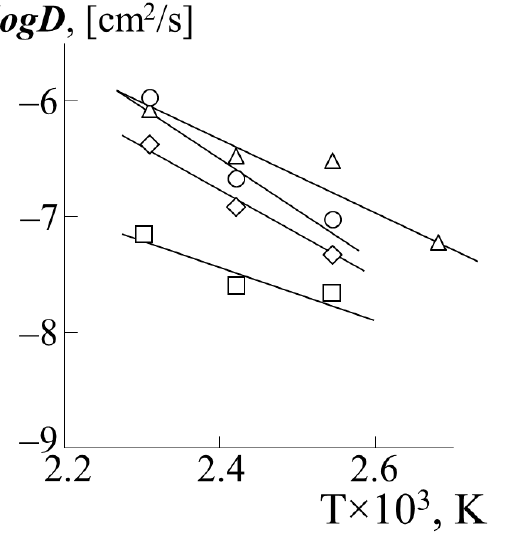
Figure 10. Temperature dependence of the partial diffusion coefficients of PS-1 into the matrix of PBA (triangle), PEA (rhombus), PMA (square) or PEHA (circle).